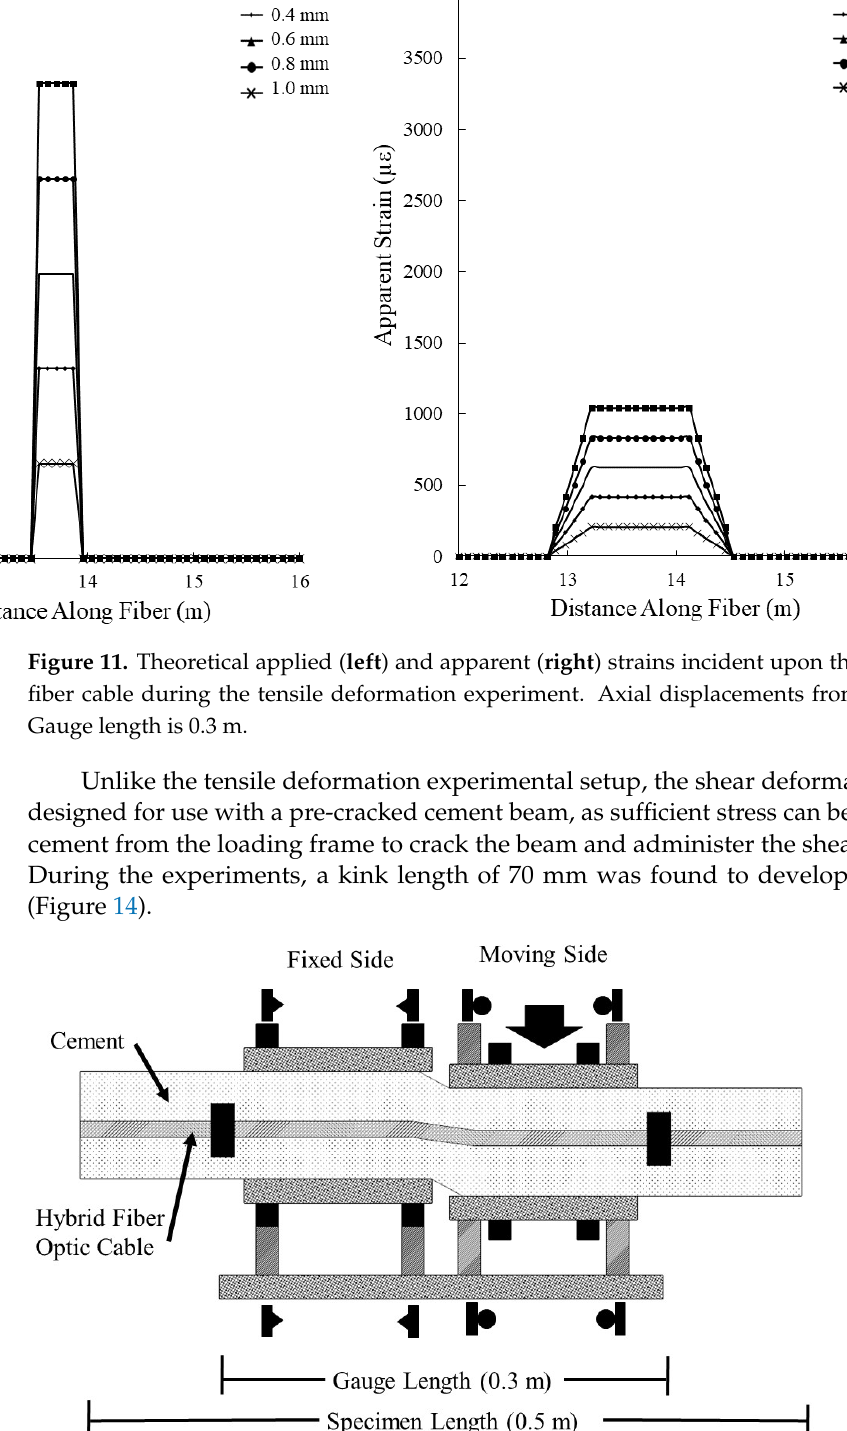
Figure 13. Shear displacement setup with cement sample with embedded hybrid fiber optic cable secured in the hydraulic loading frame. Unlike the tensile deformation experimental setup, the shear deformation setup not designed for use with a pre-cracked cement beam, as sufficient stress can be applied to the cement from the loading frame to crack the beam and administer the shear defor- mation. During the experiments, a kink length of 70 mm was found to develop in most cases (Figure 14). Assuming a constant kink length of 70 mm for the shear deformation test, the theo- retical applied and apparent strains can be calculated given the administered shear dis- placements using Equation (2) (Figure 15). Note that as the use of the hybrid fiber optic cable engages the entire length of the optical fiber between anchoring points in response to highly localized deformations in the cement beam, the applied and apparent strains presented in Figure 14 are only valid for use with the hybrid fiber optic cable, and not for a cable installed using the overall bonding technique.